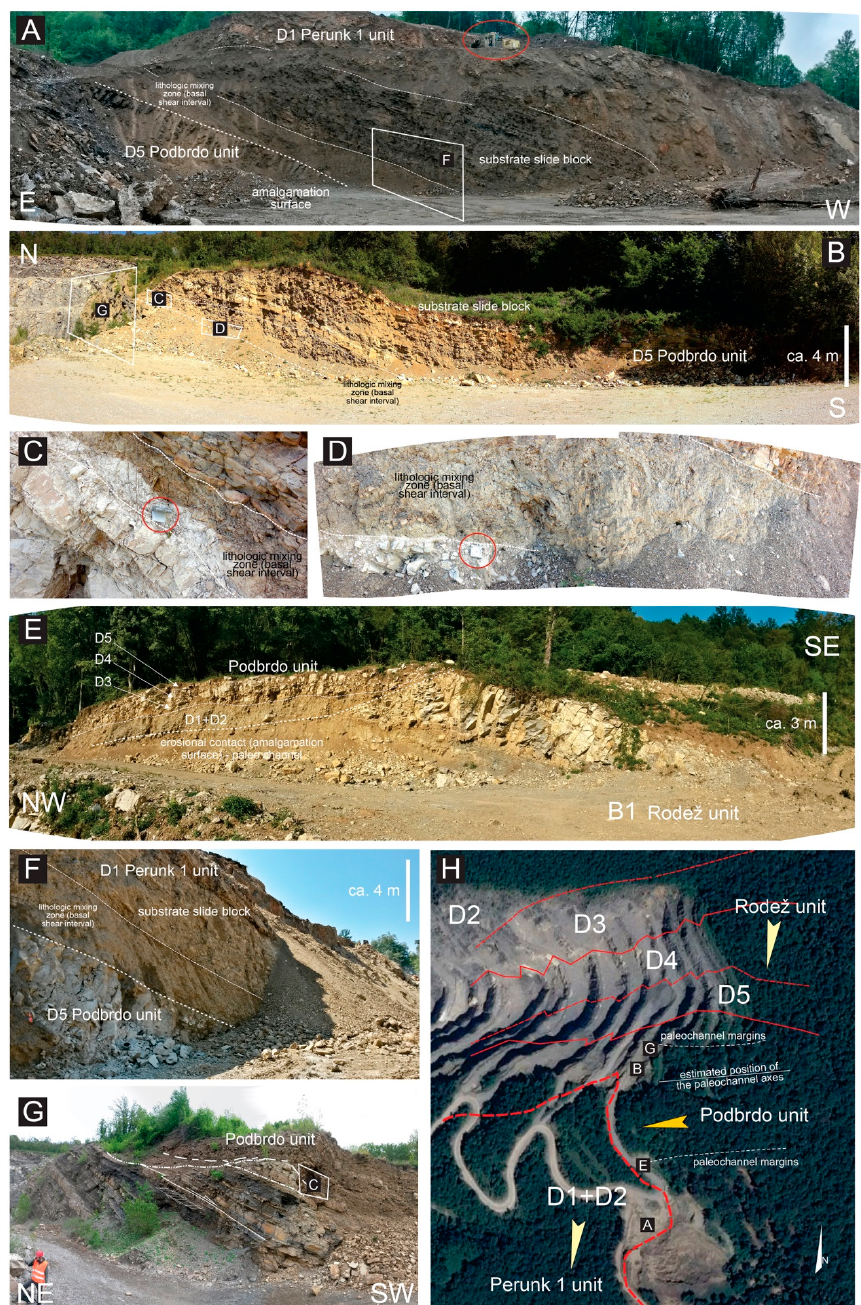
Figure 3. The stratigraphic relationship between Rodež, Podbrdo, and Perunk 1 units. ( A ). Erosive contact (basal shear zone with mechanical lithological mixing) between the D1 division of the Perunk 1 unit and the D5 division of the Podbrdo unit. Soft-sediment shearing affects the B1 background succession found on top of Podbrdo unit (circled excavator for scale). Note the clear contact between the labeled substrate rip-up and the basal mixing zone. ( B ). Erosive base of the Podbrdo unit scouring the background succession B1 overlying the Rodež unit. ( C ). and ( D ). Detail of the mechanical mixing in the basal shear zone of the Podbrdo unit, below a substrate rip-up (circled compass for scale). Locations in B. ( E ). Southern margin of the erosive basal contact of the Podbrdo unit cutting downward into the background succession B1 overlying the Rodež unit. ( F ). Close-up of the basal shear mixing zone of the Perunk 1 unit. Location in A. ( G ). Frontal erosive ramp of the Podbrdo unit cutting the background succession B1 overlying the Rodež unit. Location in B. ( H ). Aerial photograph (Google Earth image, 2018) with contouring of the Rodež, Podbrdo and Perunk 1 units, with indications of the paleotransport directions and the inferred margins of the basal erosive contact of the Podbrdo unit (locations of A, B, E and G are